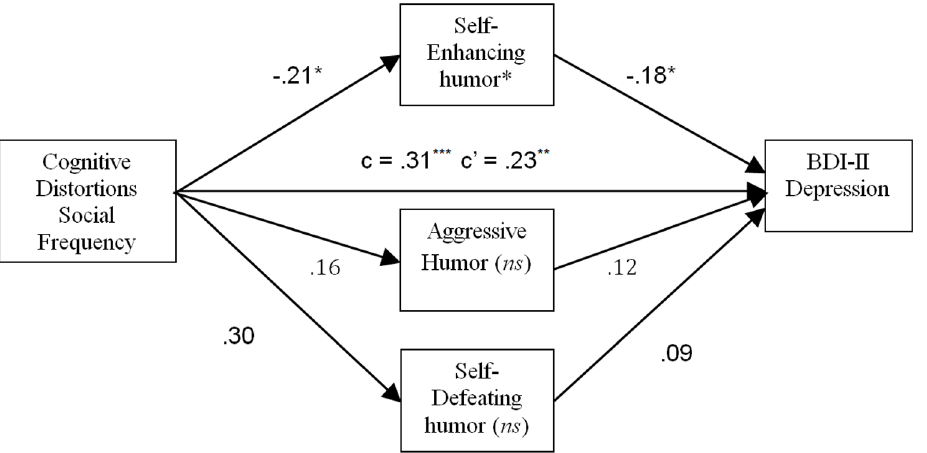
Figure 2. Mediating effect of Self-Enhancing humor on the relation between frequency of cognitive distortions in social contexts and depressive